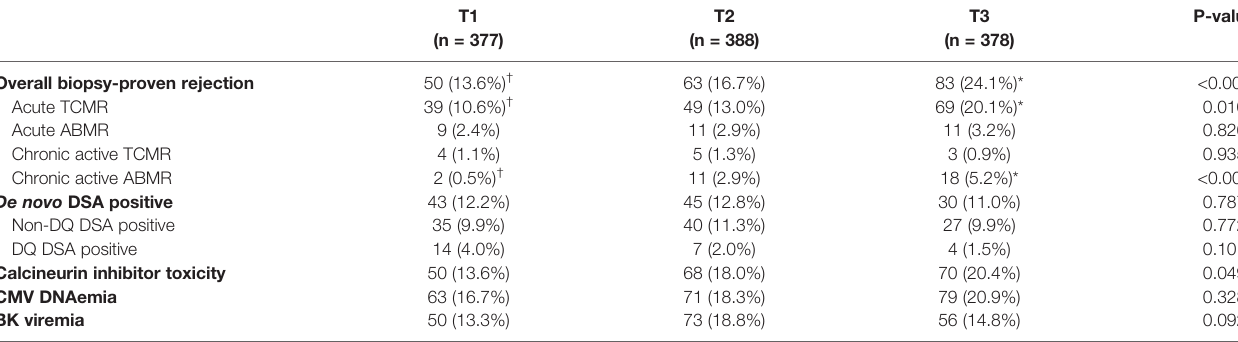
TABLE 2 | Incidences of BPAR and other complications according to TAC-C0-TWCV tertiles up to post-transplant fi rst year.